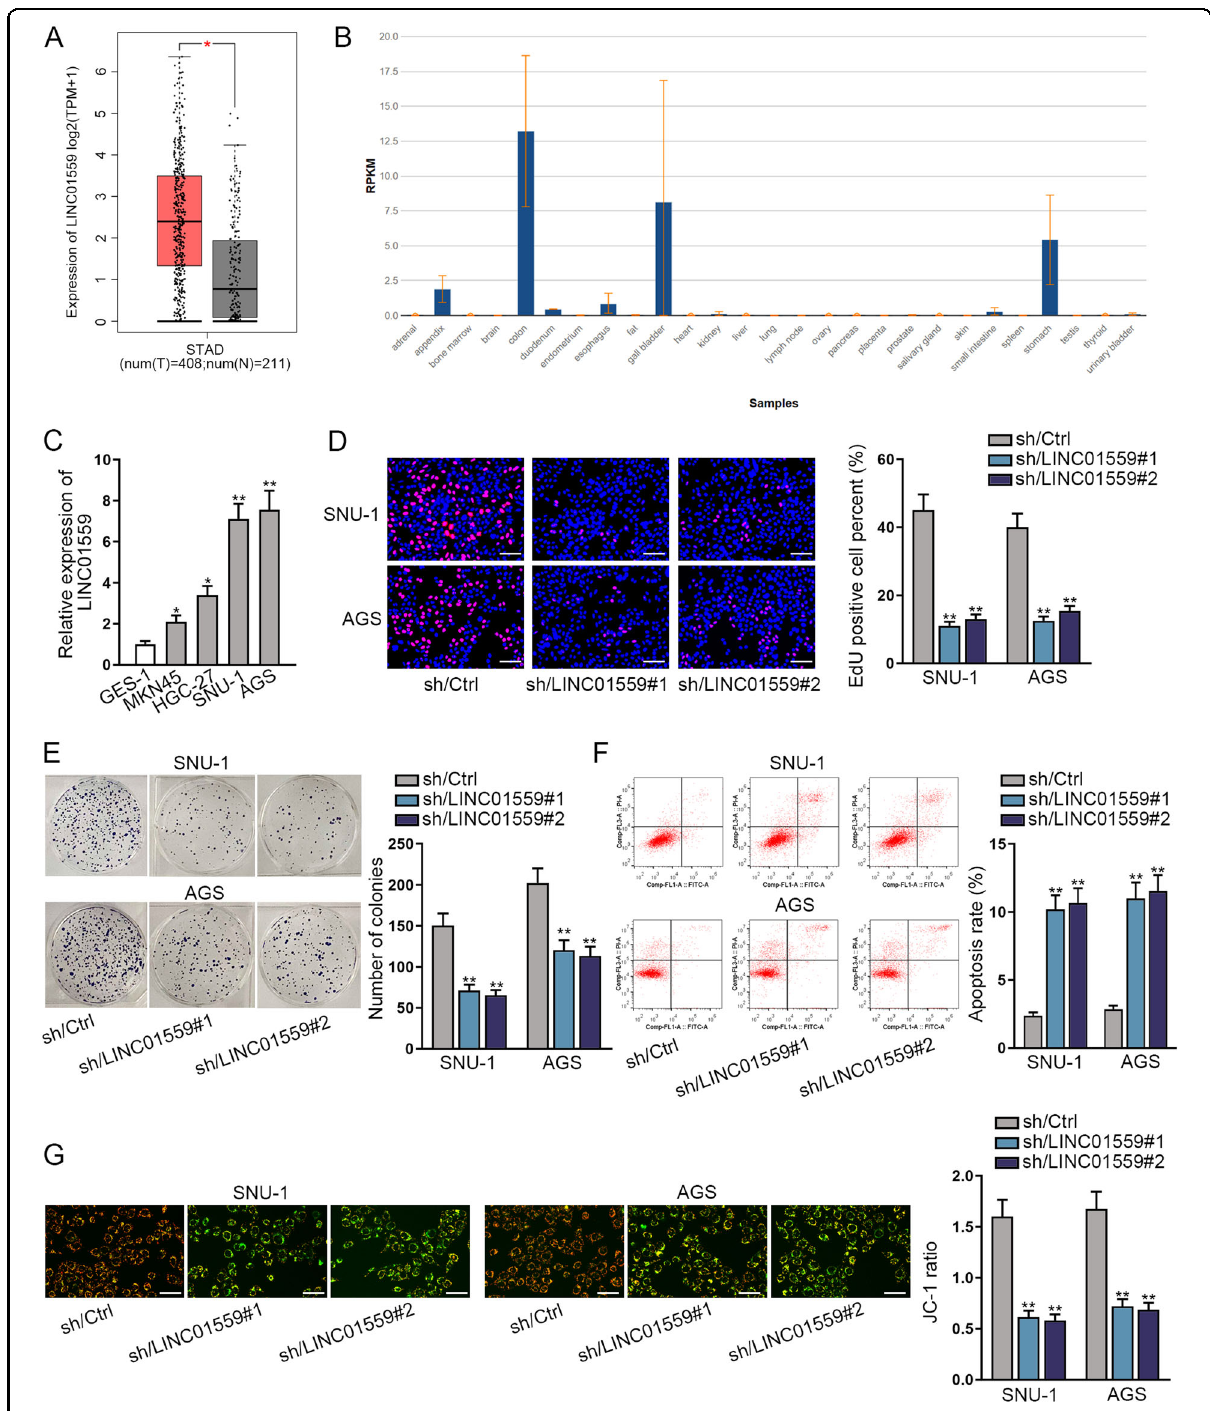
Fig. 1 Knockdown of LINC01559 suppresses the proliferation and promotes the apoptosis in GC cells. A GEPIA2 analyzed LINC01559 expression in 408 STAD tissues and 211 normal gastric tissues. B NCBI data showed LINC01559 expression pro fi le in different normal tissues. C The relative expression level of LINC01559 in four GC cell lines (MKN45, HGC-27, SNU-1 and AGS) and GES-1 cells was examined by RT-qPCR analysis. D, E EdU and colony formation experiments tested the proliferation capacity of SNU-1 and AGS cells with or without LINC01559 silence. F, G . Flow cytometry analysis and JC-1 assays detected the apoptosis in SNU-1 and AGS cells before or after LINC01559 silence. * P < 0.05, ** P <